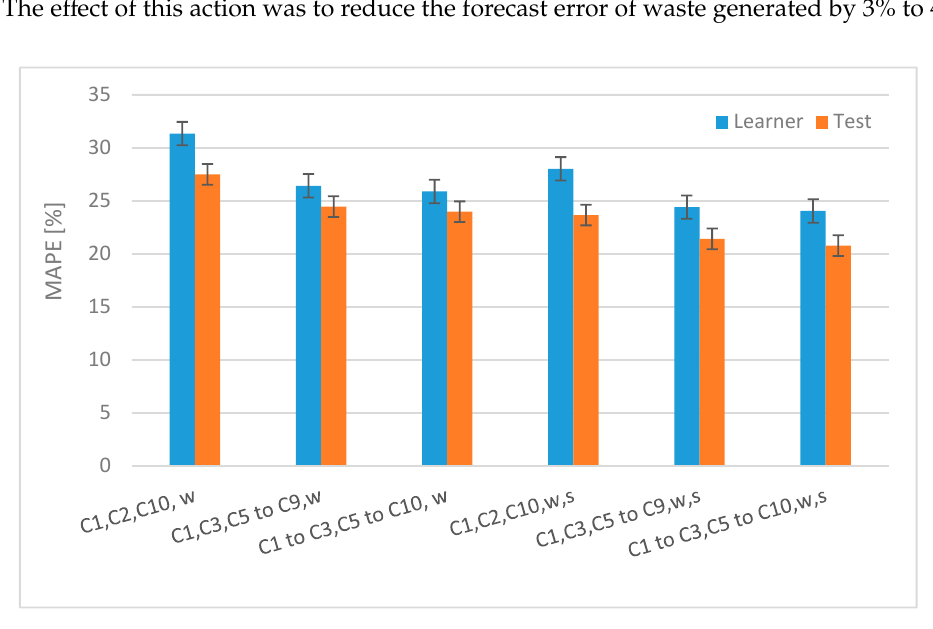
Figure 9. Assessment of the quality of the developed models of the total waste accumulation indicator from households for determined clusters in a varied system of input variables. To better present the size of the obtained errors of combined predictions of the mass waste accumulation indicator in relation to the selected set of explanatory variables, error distribution functions were developed and presented in the diagram (Figures 10 and 11).